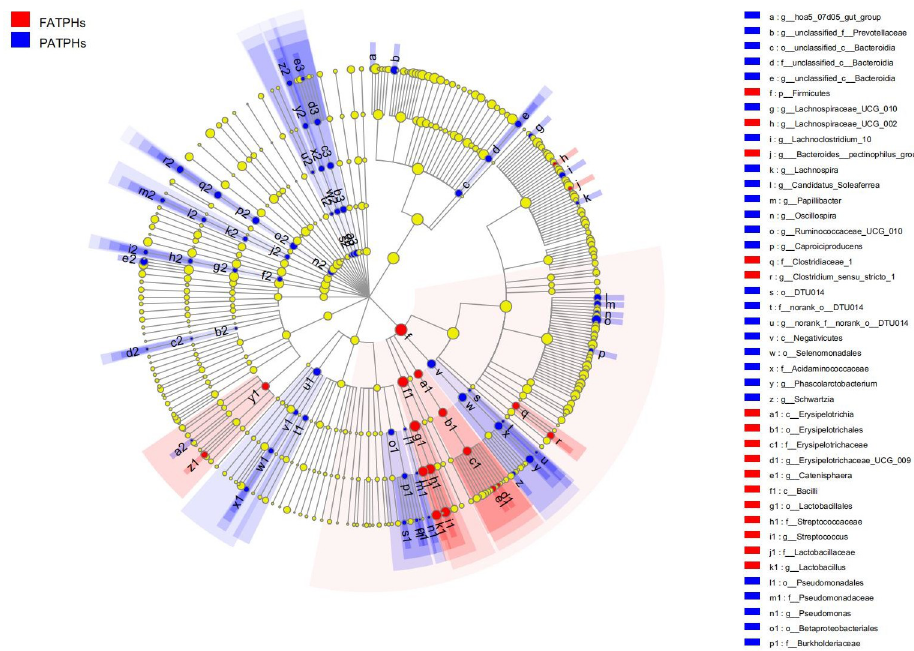
Fig 4. LEfSe cladogram showing a range of bacterial taxa at level of phylum to genus associated with the FATPHs (red) and PATPHs (blue) ( α = 0.05, LDA > 2.0); the circle size represents the relative abundance of each taxon; the yellow circle indicates that the taxon has no significant difference between the FATPHs and